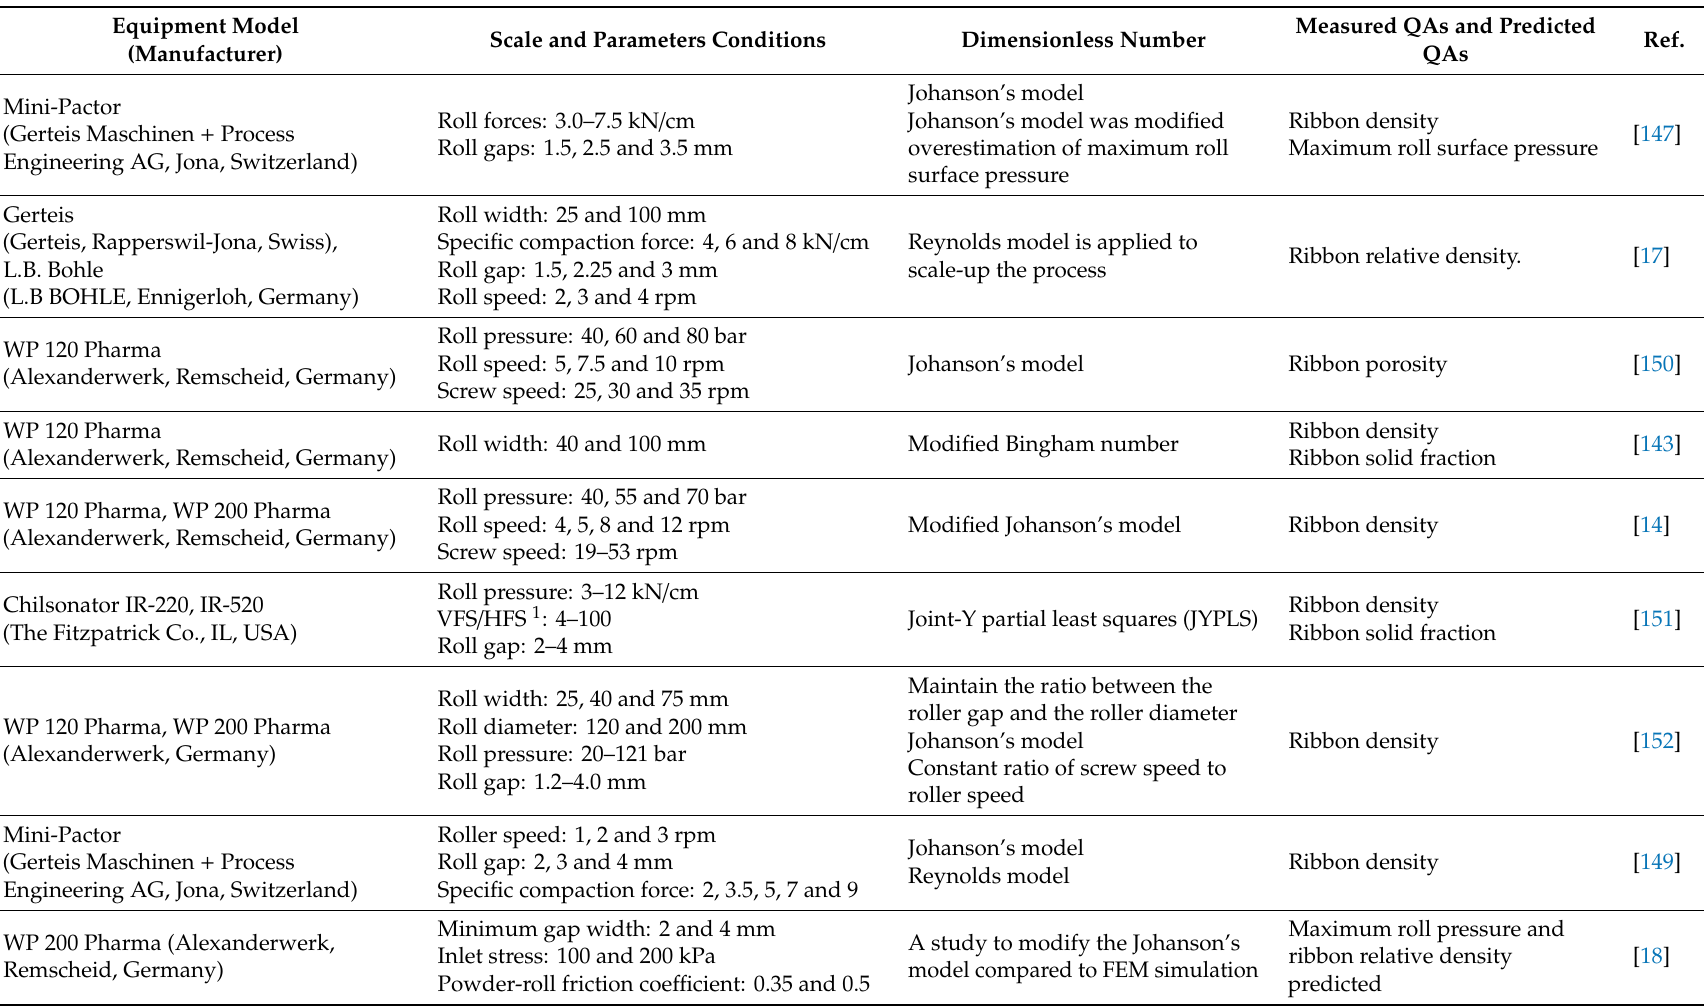
Table 6. Summary of engineering-based modeling method applied in dry granulation